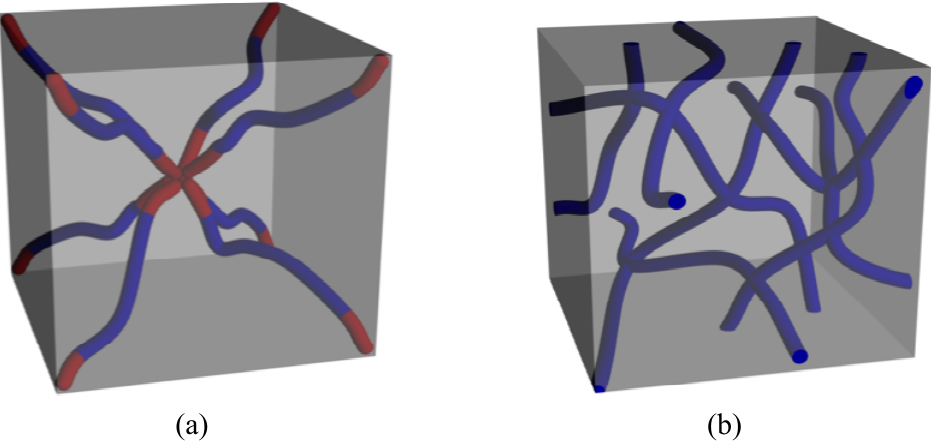
Figure 2. Schematic illustrations of (a) a physical gel created through non-covalent bonding and (b) a chemical gel created by chemical cross-linking. Note: the red domains in (a) represent the aggregated